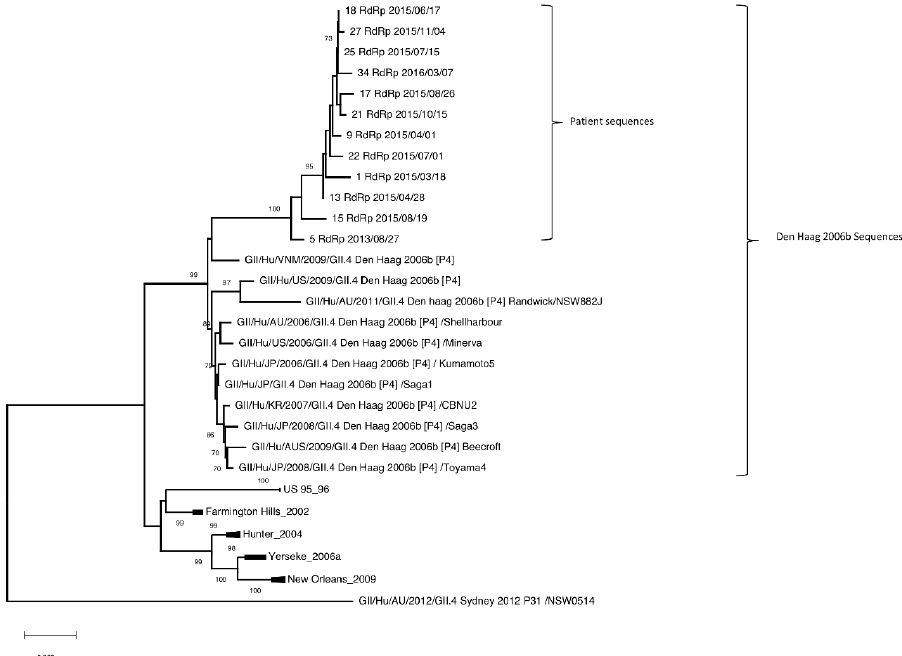
Figure 2. Phylogenetic tree built from RdRp gene of norovirus in the patient samples with reference sequences obtained from NCBI for comparison. Patient samples are designated with Sample-ID, gene name, and date of collection (YYYY/MM/DD). All Den Haag strains used for comparison are shown. Strains within other variants are minimized but can be found in Supplementary Table S2.